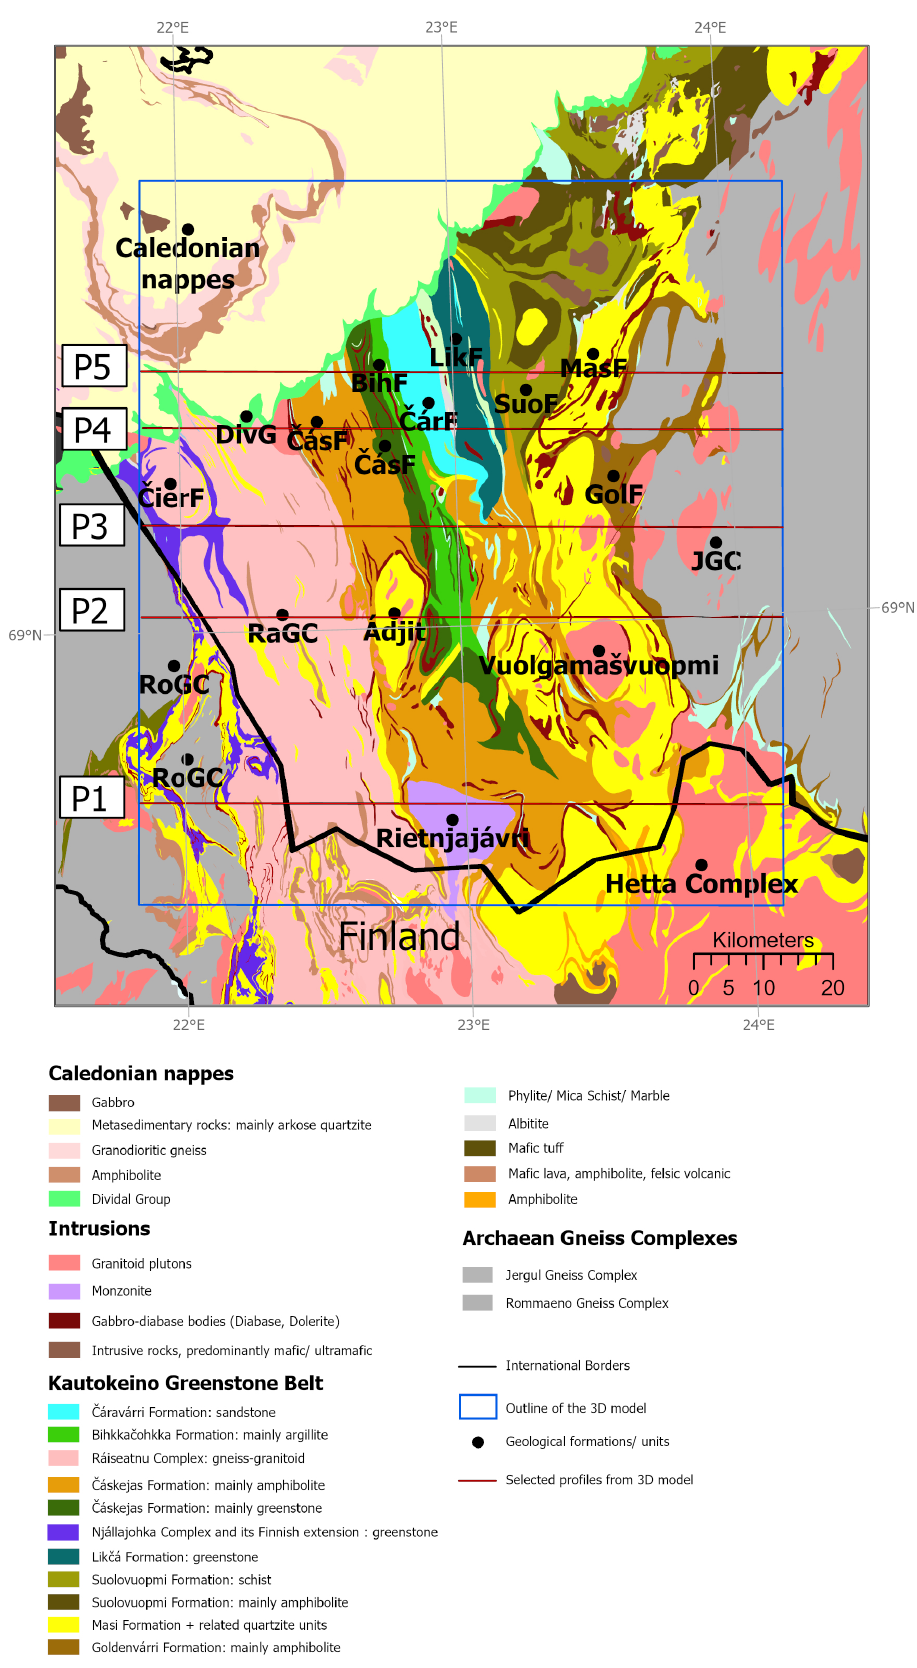
Figure 2. Bedrock geological map of the study area. The map is modified from the bedrock map of Norway at a scale of 1:250.000 (Olesen & Sandstad 1993) and the bedrock map of Finland at a scale of 1:200.000 (Karinen et al., 2015). BihF= Bihkkačohkka Formation, ČárF= Čáravárri Formation, ČásF= Čáskejas Formation, ČierF= Čierte Formation, DivG= Dividal Group, GolF= Goldenvárri Formation, JGC= Jergul Gneiss Complex, LikF= Likčá Formation, MasF= Masi Formation, RaGC= Ráiseatnu Complex, RoGC= Rommaeno Gneiss Complex, SuoF= Suolovuopmi